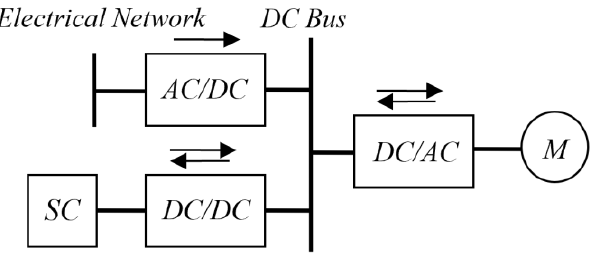
Figure 11. A combined lift electric drive system with a power supply network as the main energy source and a backup source FC .